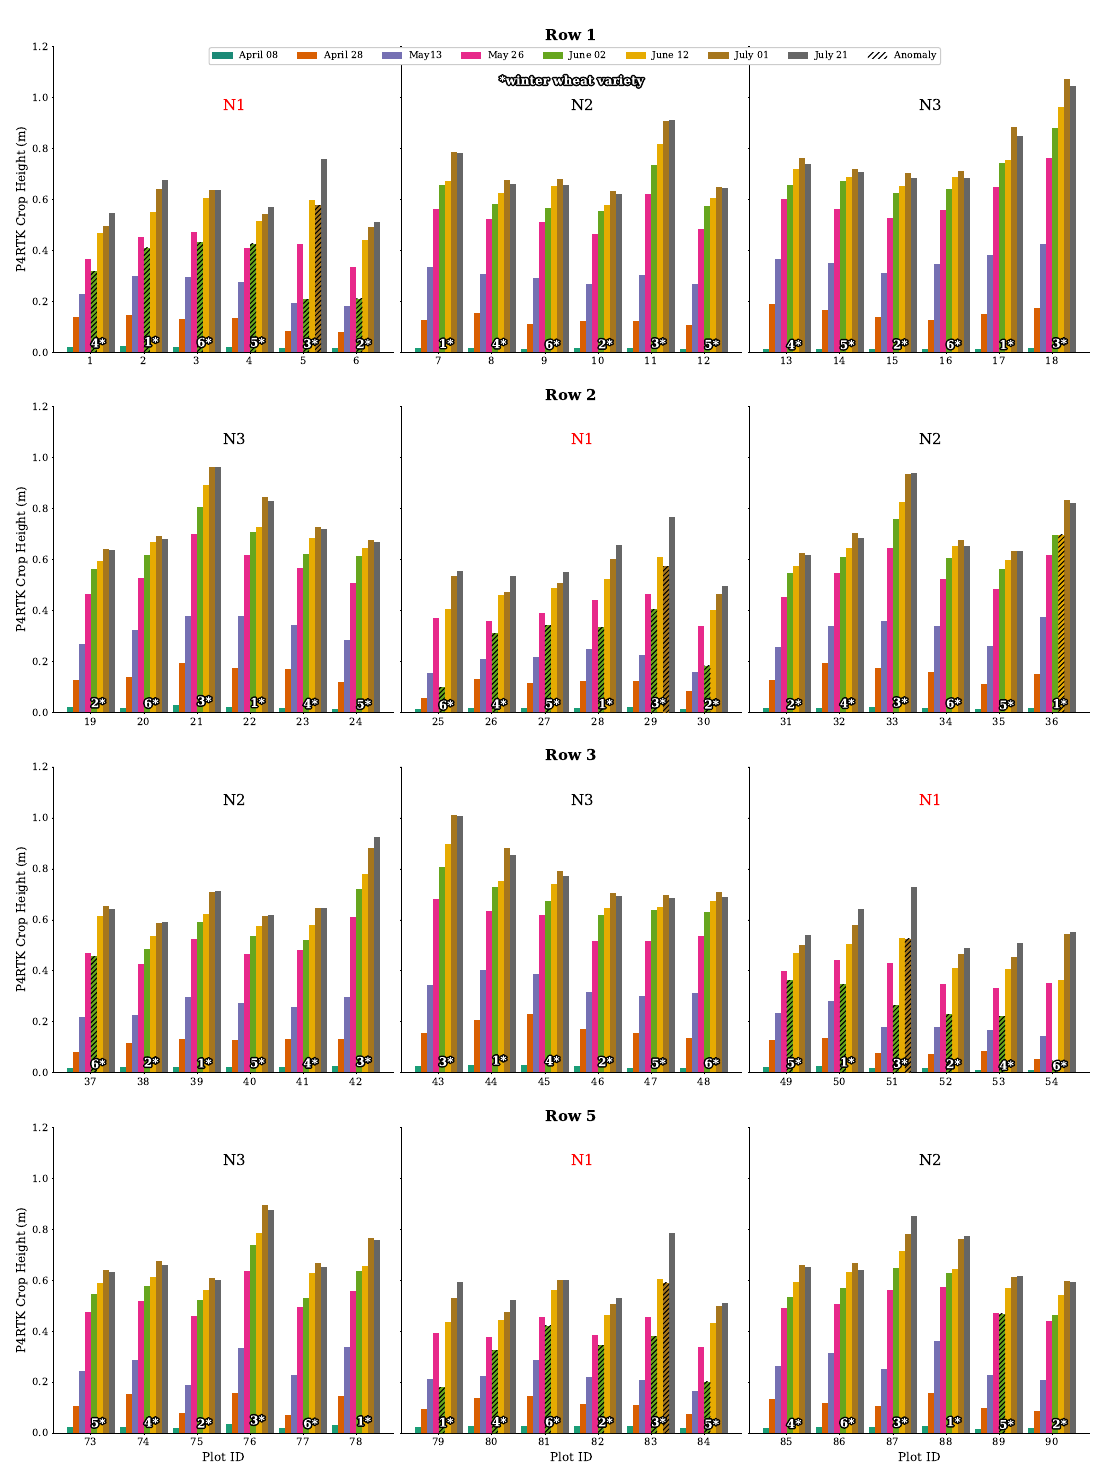
Figure A1. Graphical visualization of CH values for all relevant flight dates and all winter wheat varieties of rows 1, 2, 3, and 5 of the experimental field. The unexpectedly derived negative plant growth for the 2 June flight date by the crop height workflow is mainly found in the N1 plots, with three exceptions. Another noticeable phenomenon is the drop-in crop growth of variety no. 3 in all N1 stages of flight date 1 July. The corresponding erroneous CH values are marked with a hatched overlay in